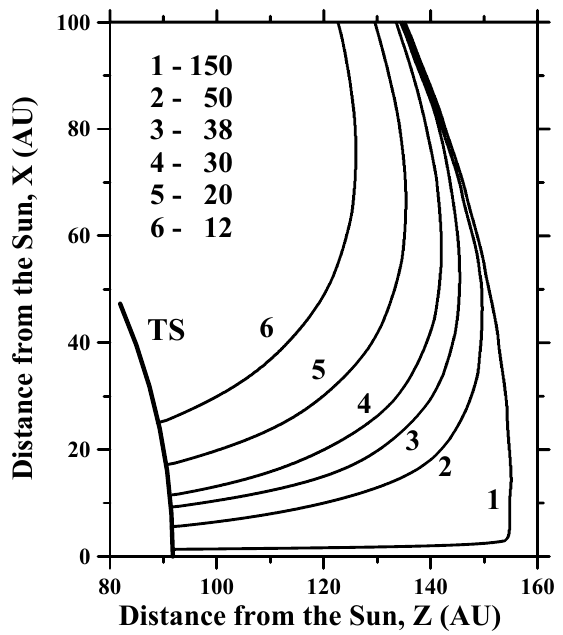
Fig. 1. Streamlines of the plasma flow in the nose part of the inner heliosheath. The HP is traced by the streamline 1 after it passes the stagnation point. The numbers in the upper left part of the figure show the number of a line and the corresponding time T conv (in years), which is needed for a solar wind parcel to move along this streamline away from the TS up to X =